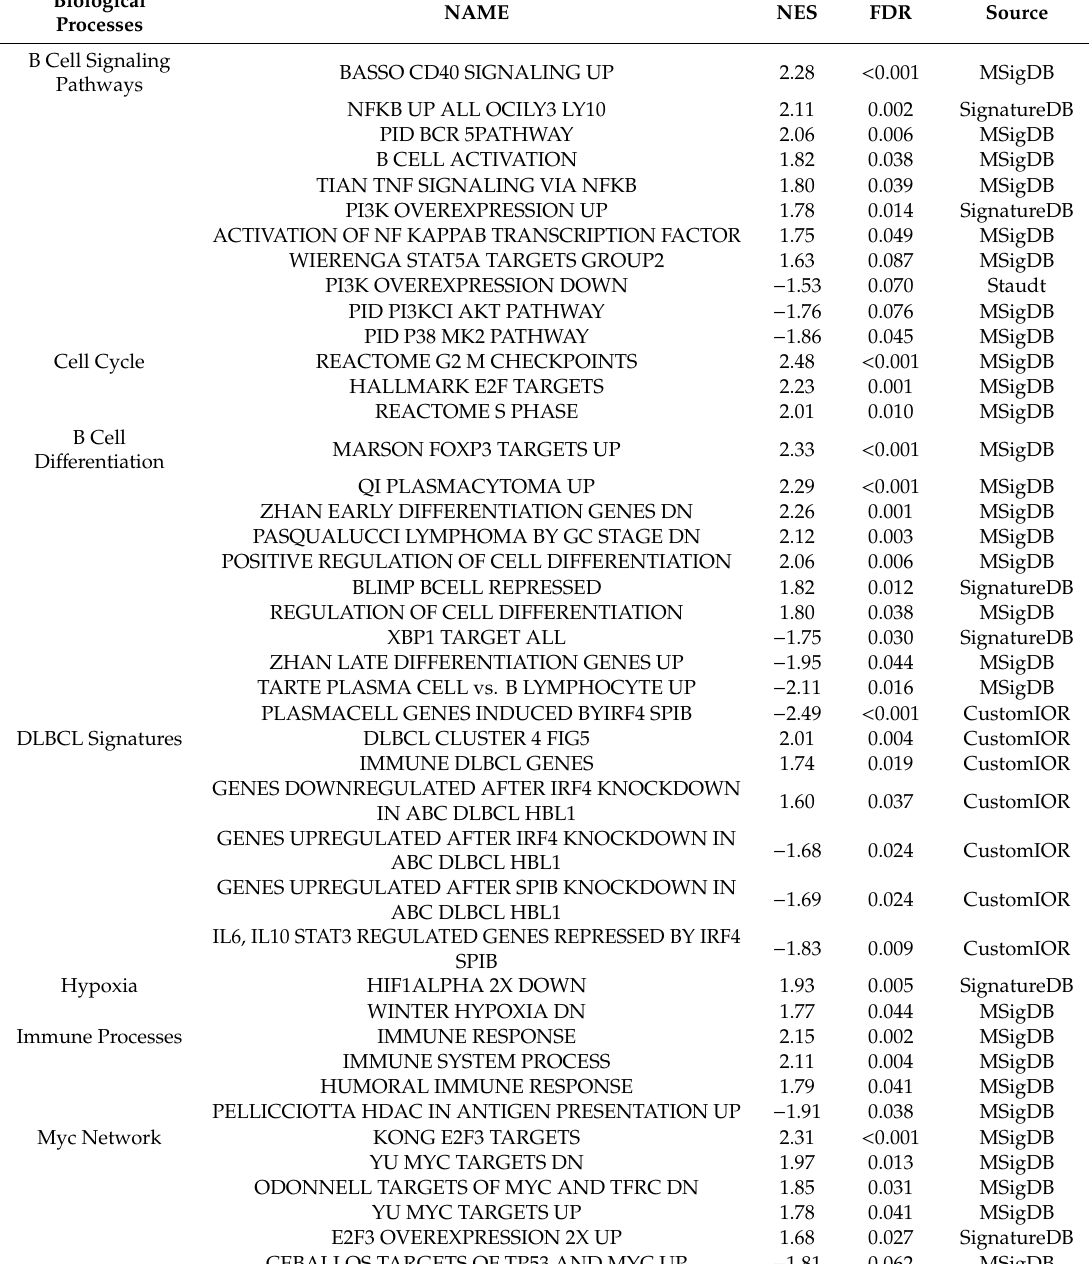
Table 1. Summary of GSEA results for microarray data comparing ETS1 knockdown versus control in ABC-DLBCL cell